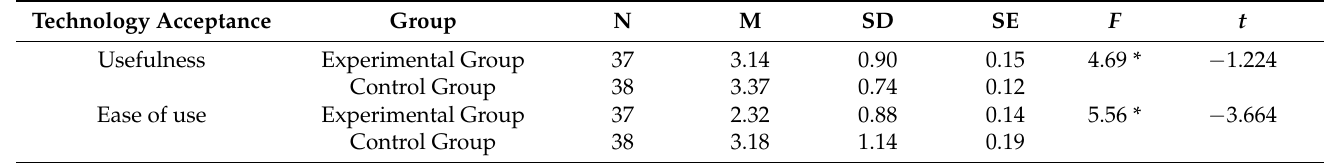
Table 5. The independent t -test analysis on technology